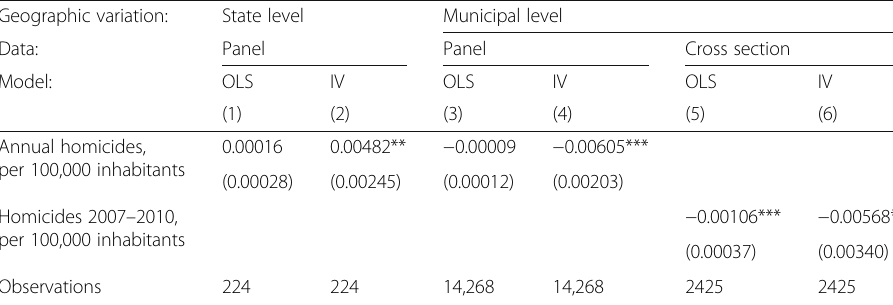
Table 5 OLS and second stage IV results: international migration Geographic variation: State level Municipal level Data: Panel Panel Cross